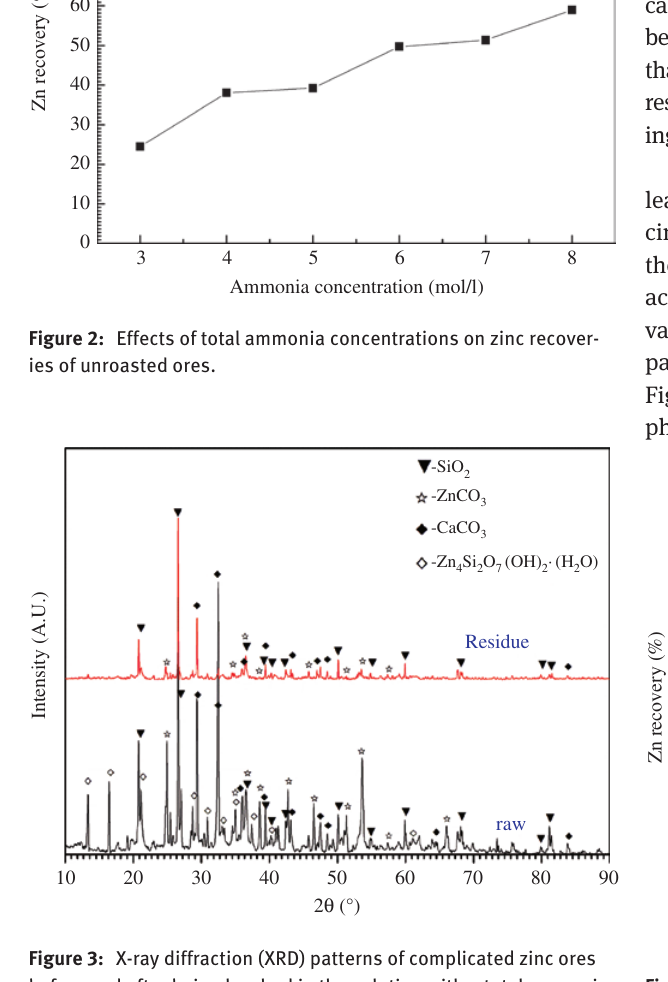
Figure 4: Zinc leaching recoveries of ores roasted at different